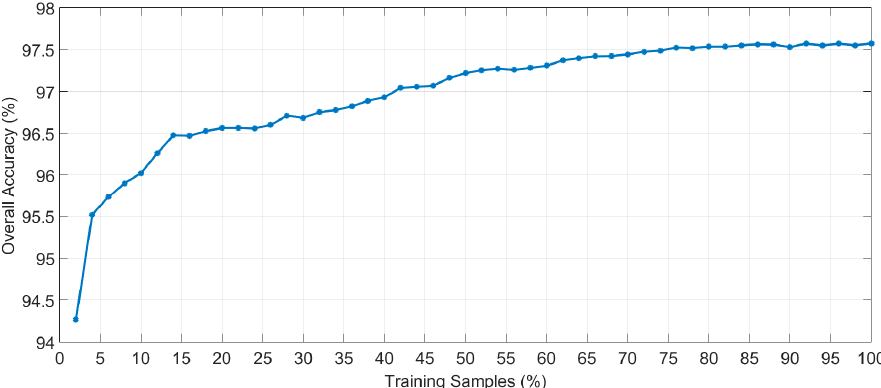
Figure 7. Overall accuracy evolution depending on the percentage of training samples employed to generate the supervised classification model of the HS brain cancer detection algorithm.